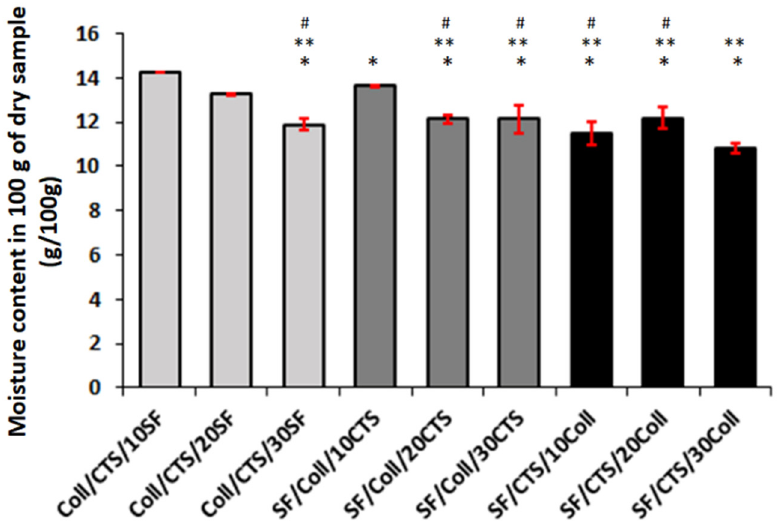
Figure 3. Results for the moisture content measurements of three component materials cross-linked by glyoxal solution ( n = 3, mean ± SD, * significantly different vs. Coll/CTS/10SF, ** significantly different vs. Coll/CTS/20SF, # significantly different vs. Coll/CTS/30SF, p < 0.05).